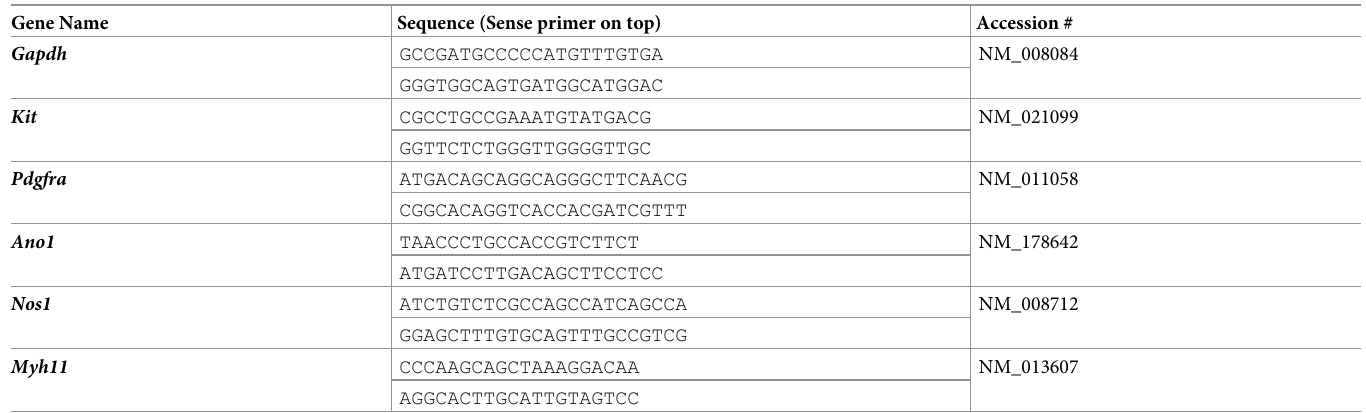
Table 1. Details of primers